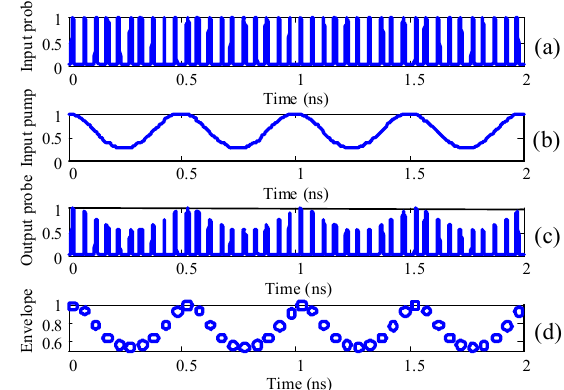
Fig. 4 Normalized powers of the (a) input probe light and (b) input pump light; normalized powers of the (c) output probe light and (d) output probe